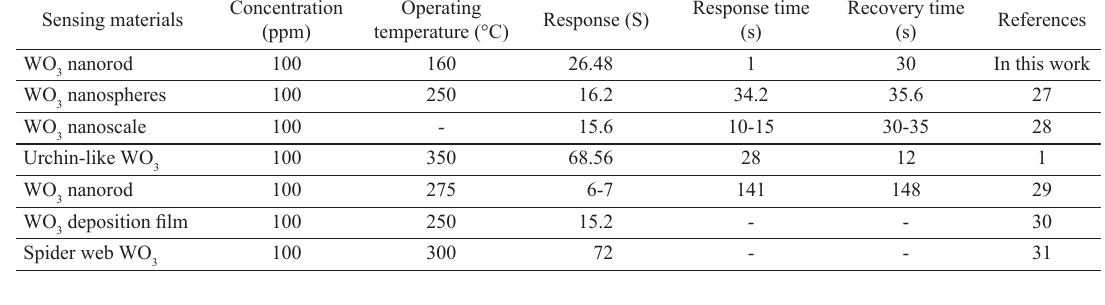
Table 3. Gas sensors for ethanol detection reported in literatures and in this work. Sensing